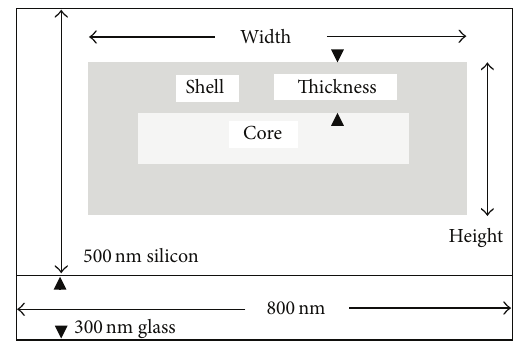
Figure 1: Sketch of a core-shell nanowire in the simulation